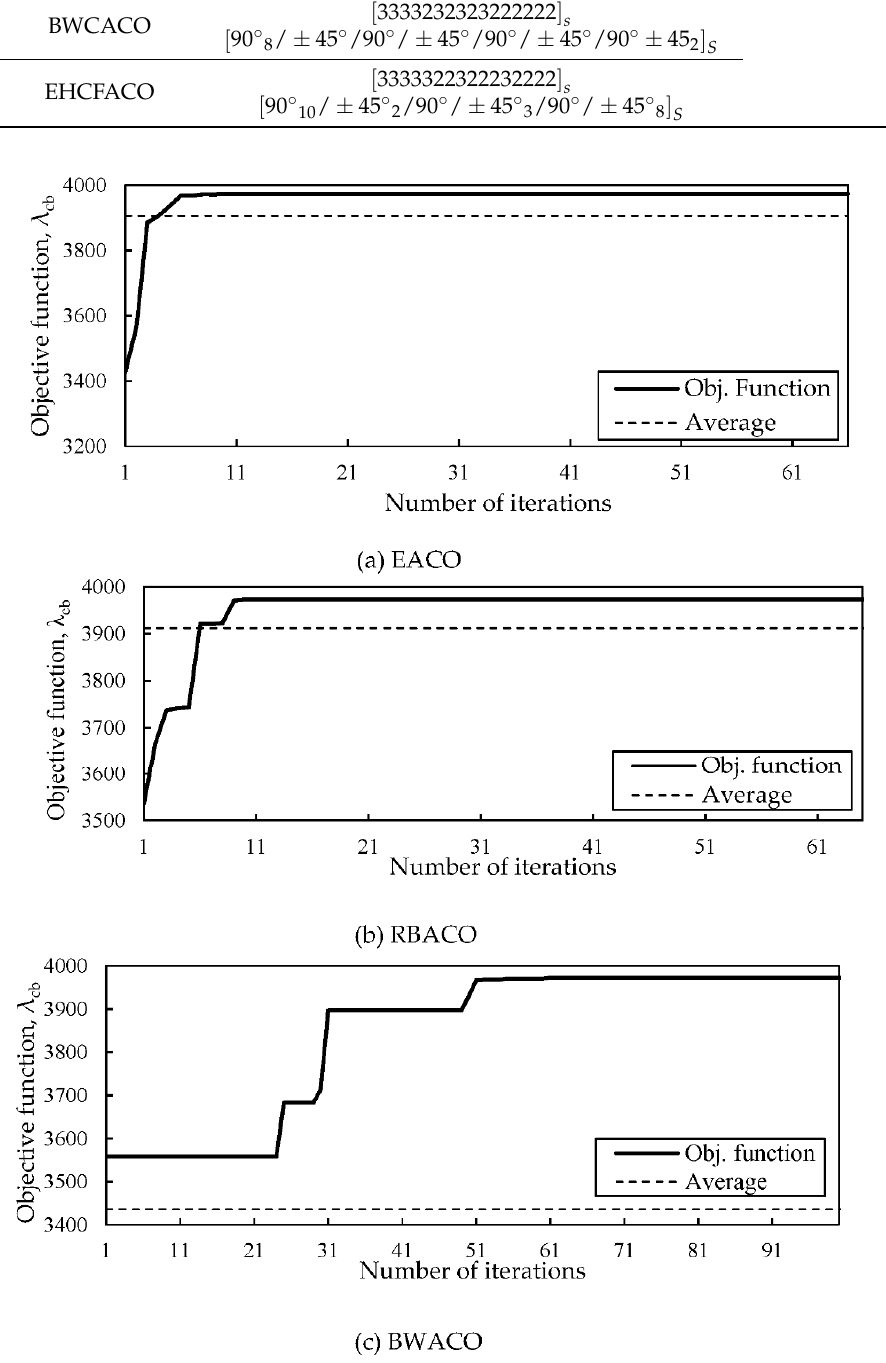
Figure 4. Solution convergence of EACO, RBACO, and BWACO.